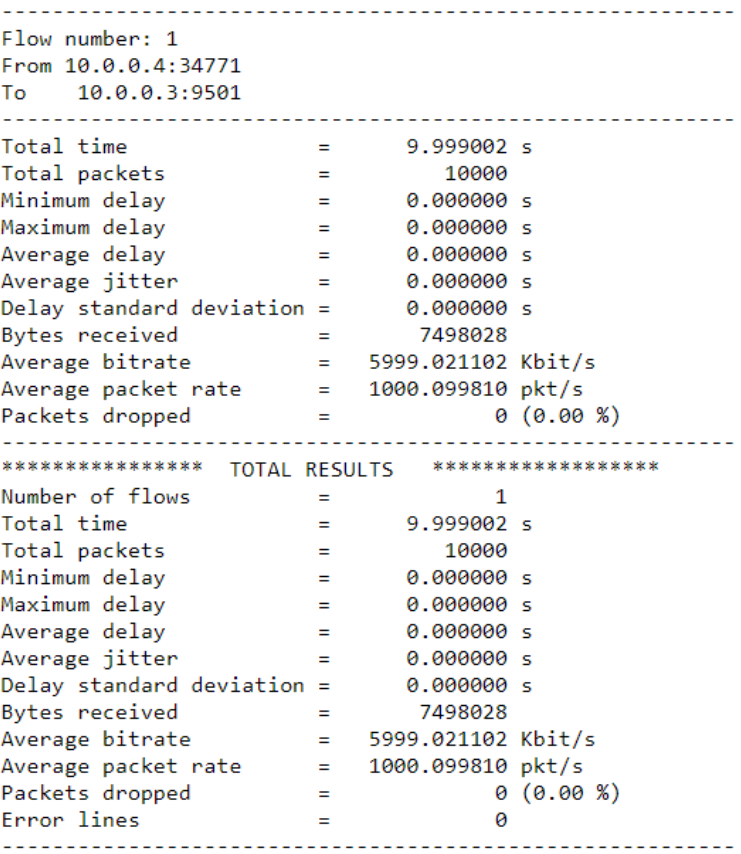
Figure 5. Snapshot of a D-ITG